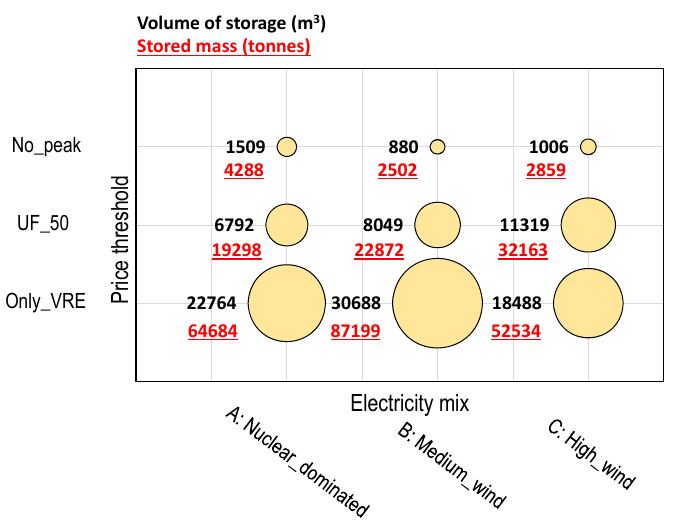
Figure 9. Sizes of the inventories of reduced material required (in tonnes) and the corresponding storage volumes, for the nine scenarios under investigation.